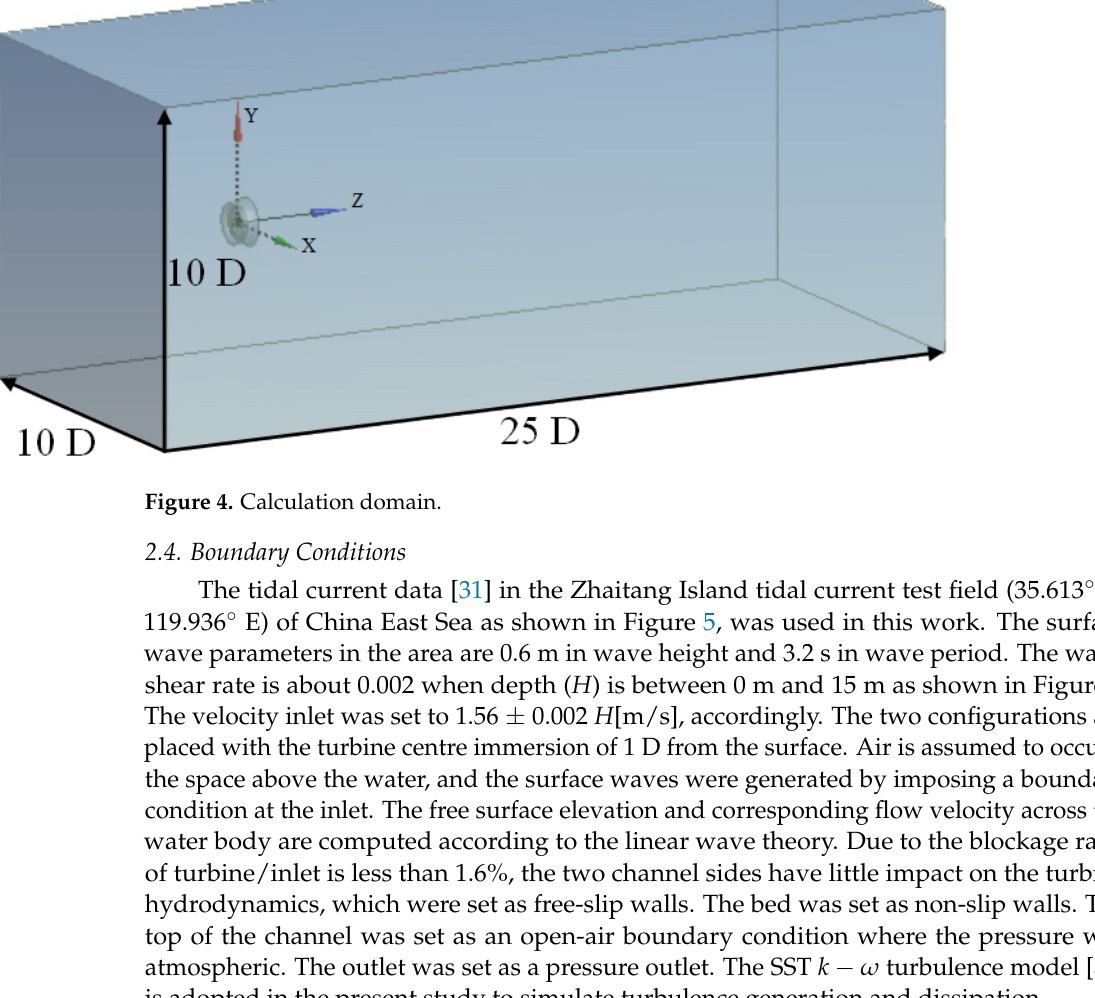
5 of 20 Figure 3. Schematic view of the DT and the RDT.